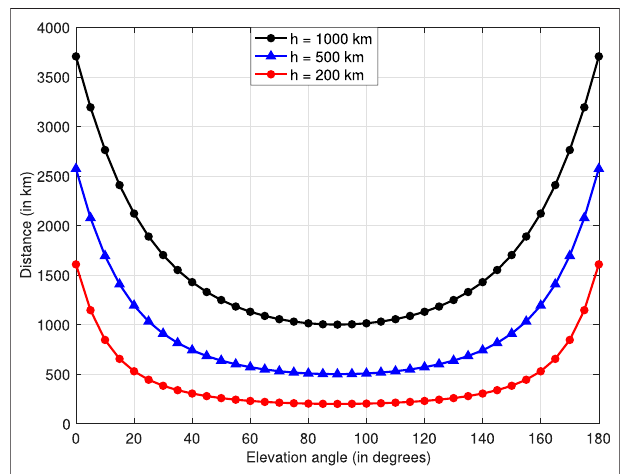
FIGURE 7 | Path length of the satellite-to-eVTOL link as a function of satellite altitude and elevation angle.